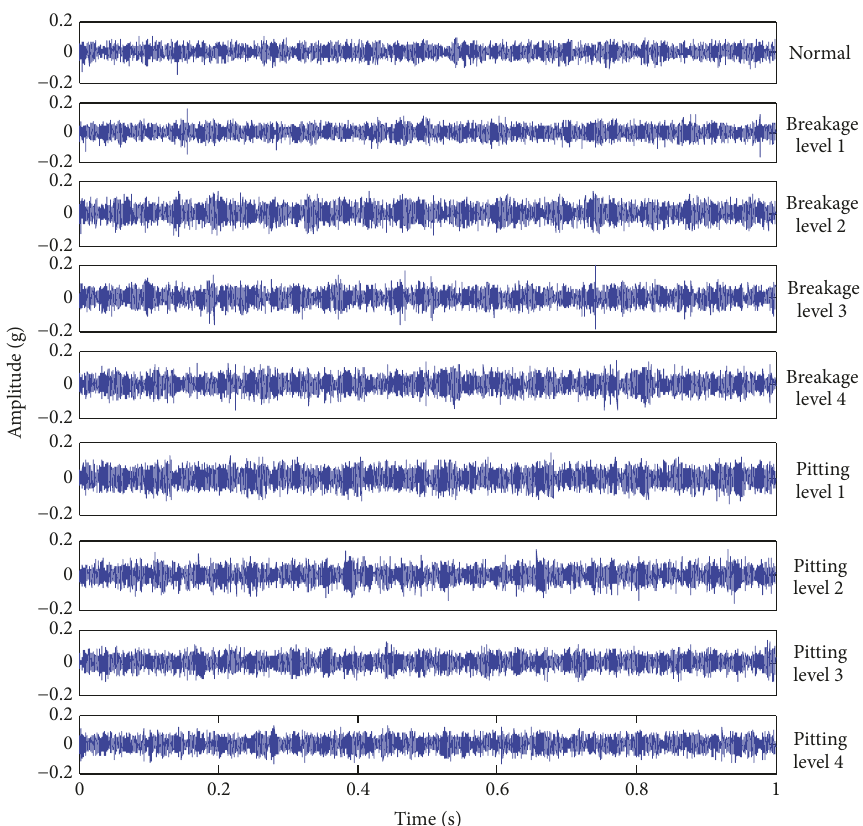
Figure 5: Vibration signals of normal planetary gear and different degradation